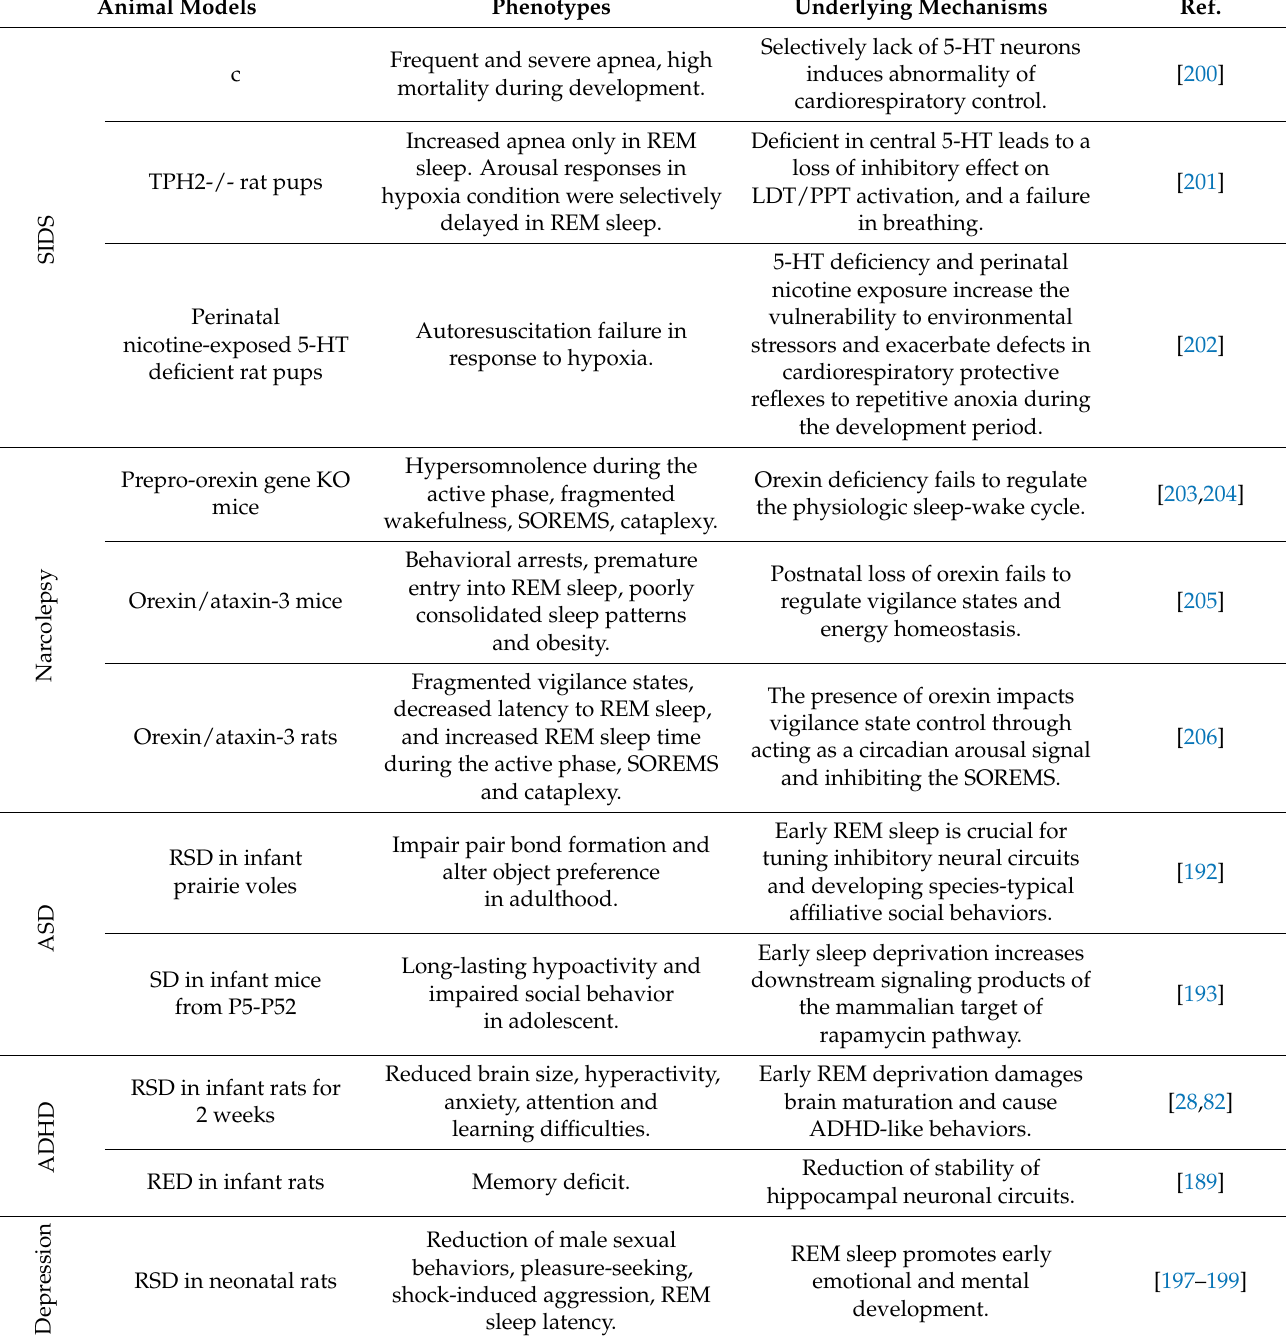
Table 4. Animal models for underlying mechanisms involved in the neurodevelopmental disorders associated with REM sleep